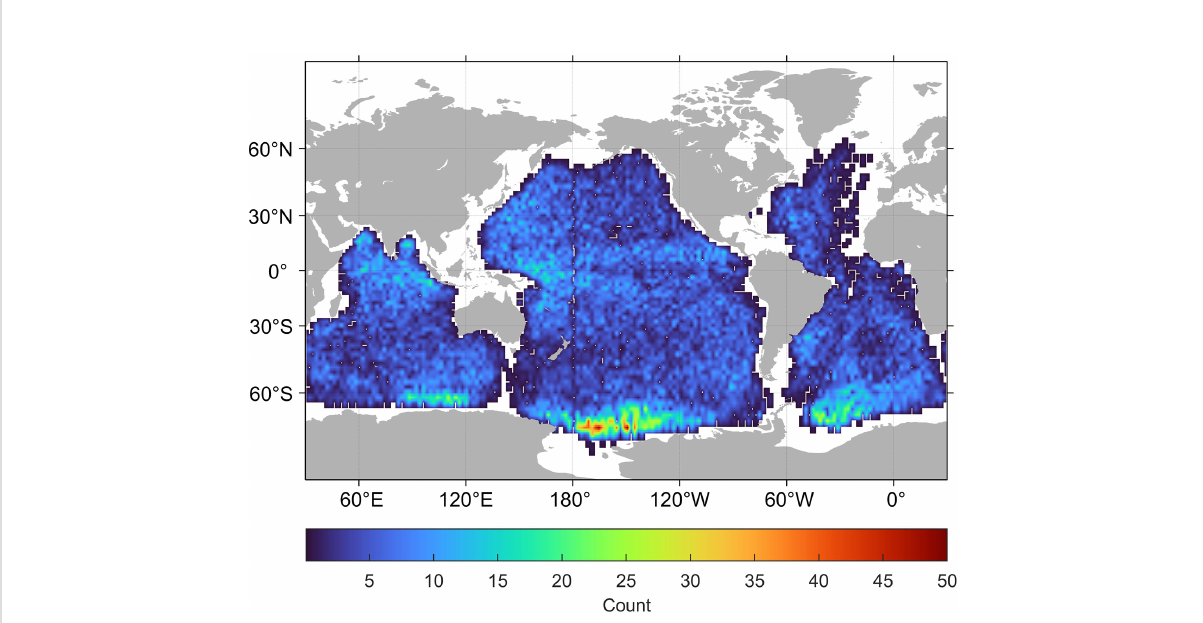
FIGURE 2 SAR data coverage under VV polarization in 2016. The color represents the number of WV images within each 5° by 5° spatial